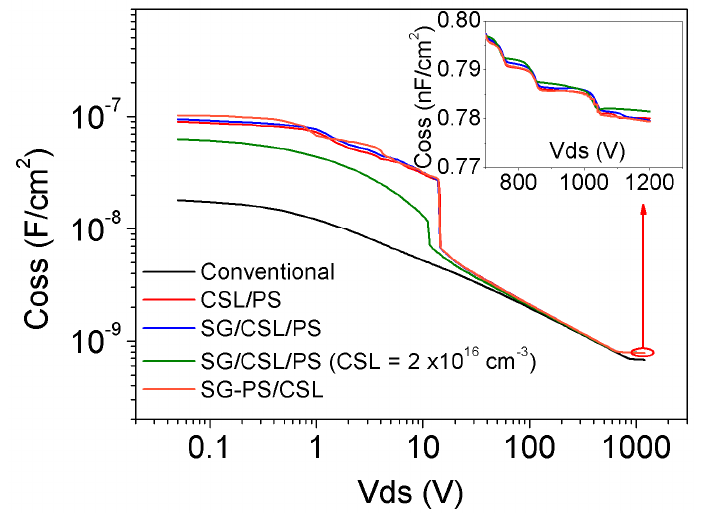
Figure 6. Coss of conventional, CSL/PS, SG–PS/CSL, and SG/CSL/PS, with different CSL doping concentrations. The frequency is at 1 MHz and Vgs is 0 V. If not otherwise specified, the CSL doping concentration is 9 × 10 16 cm − 3 .